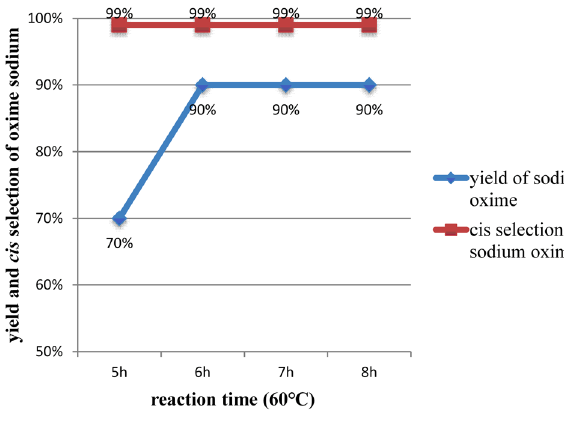
Figure 3: E ff ect of reaction time on the yield of sodium oxime and proportion of cis - sodium oxime at 60 ℃ .